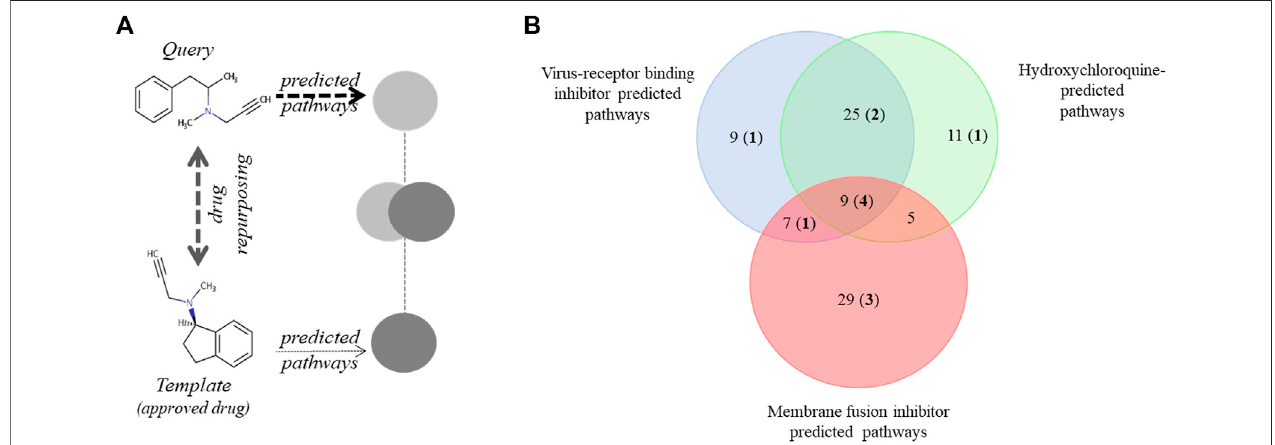
FIGURE 1 | Pathway-based drug repurposing and overlap among three predicted and an experimentally veri fi ed pathway data set. (A) Illustration of pathway- based drug repurposing. A prede fi ned pathway pro fi le obtained for a query drug (outlined in Supplementary Figure S1 ) is screened against a data set of template drugs with pre-calculated pathway pro fi les (for example, clinically approved drugs). Interesting drugs relevant for repurposing applications are obtained via maximizing pathway overlap. (B) Pathways predicted tobe involvedin SARS-CoV-2 infection were identi fi ed usingthree drugsshown tobe active against SARS-CoV: avirus- receptor binding inhibitor: SSAA09E2, viral and cellular membrane fusion inhibitor: SSAA09E3 and hydroxychloroquine. Numbers in bold and parenthesis indicate the numberofpathwaysalsodetectedinanexperimentaldatasetbyZhouetal.(2020).KEGGpathwaysinvolvedinthisanalysisareshownin SupplementaryMaterial2